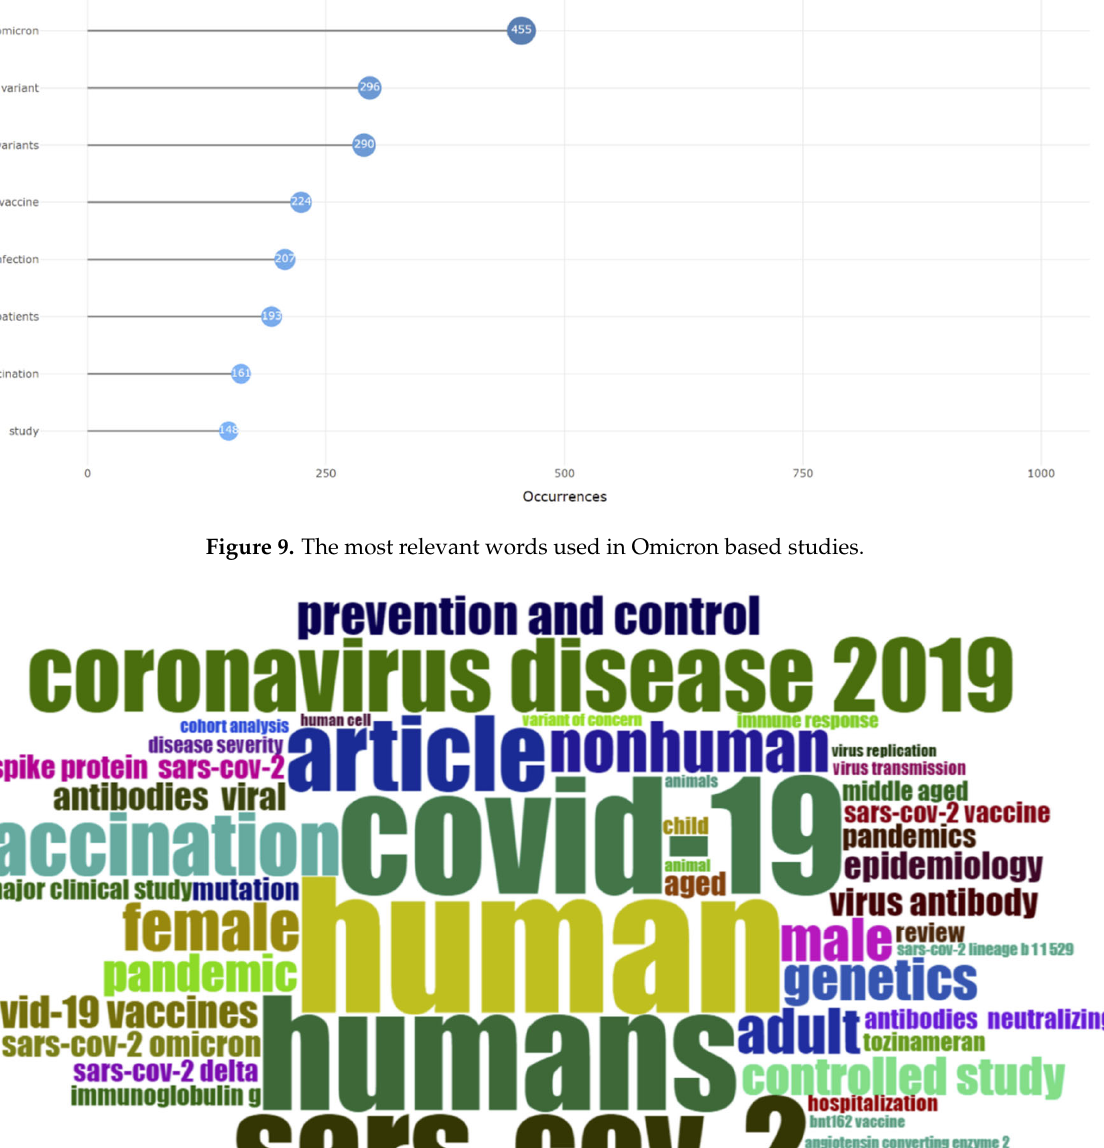
Figure 11. Relationship found in Omicron ‐ based research between countries, authors, and key ‐ words.